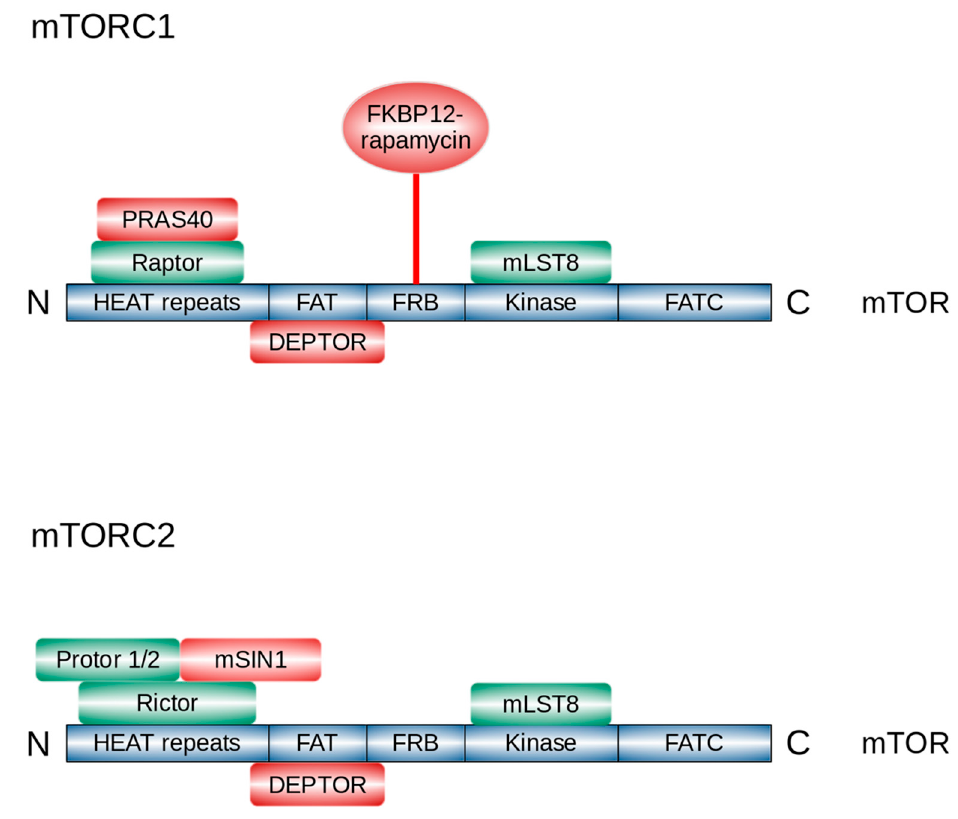
Figure 1. Domain structure of mTOR and components of mTORC1 and mTORC2. DEPTOR, DEP domain-containing mTOR-interacting protein; FAT, FRAP/ATM/TRRAP; FATC, FRAP/ATM/TRRAP/Carboxy terminal; FKBP-12, FK506-binding protein-12; FRB, FKBP12-rapamycin-binding; HEAT, Huntingtin/Elongation factor 3/A subunit of protein phosphatase-2A/TOR1; mLST8, mammalian lethal with SEC13 protein 8; mSIN1, mammalian stress-activated protein kinase interacting protein 1; mTOR, mechanistic target of rapamycin; mTORC1, mTOR complex 1; mTORC2, mTOR complex 2; PRAS40, proline-rich AKT substrate 40 kDa; Protor, protein observed with RICTOR; RAPTOR, regulatory-associated protein of mTOR; RICTOR, rapamycin-insensitive companion of mTOR. The picture was modified from [53].